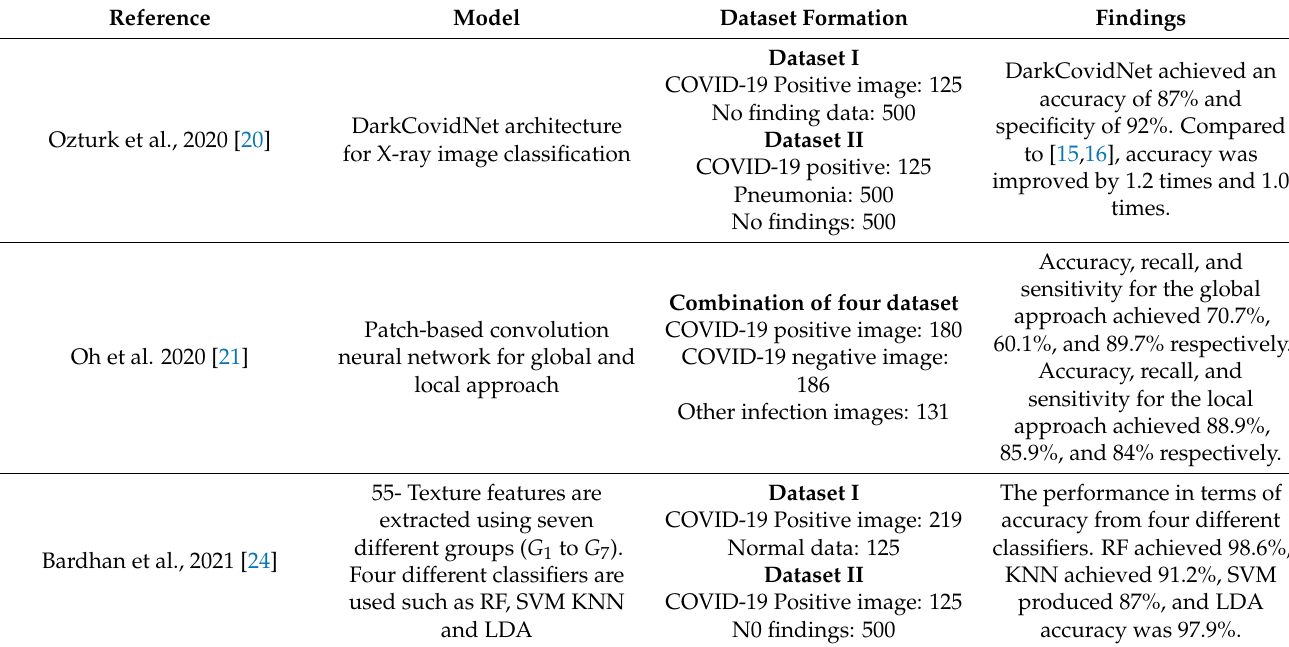
Table 1. Literature study of the related works for COVID-19